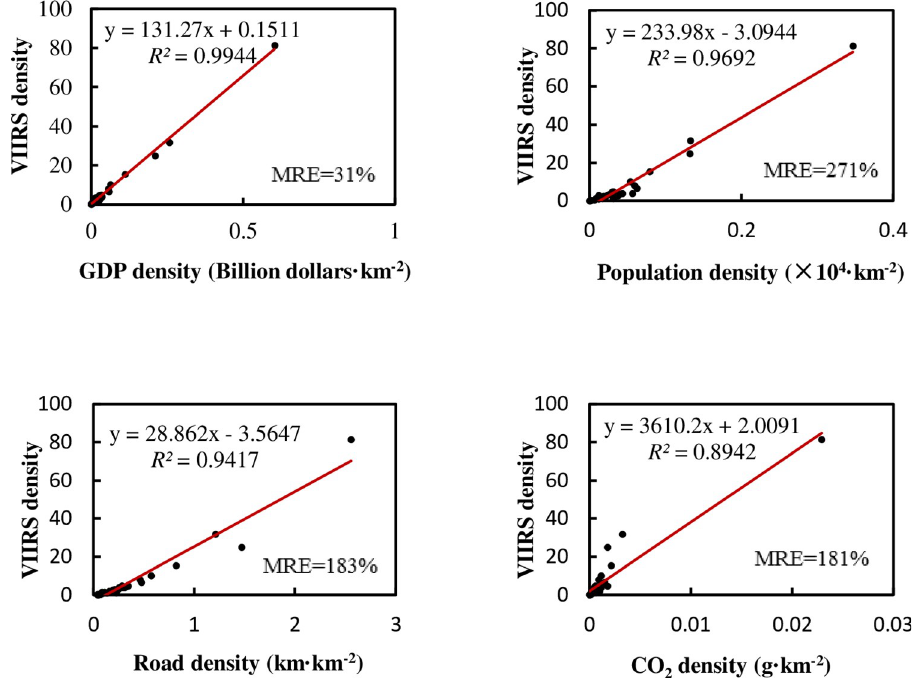
Fig 4. Relationship between NTL density and the density of various elements in provincial administrative regions of China.